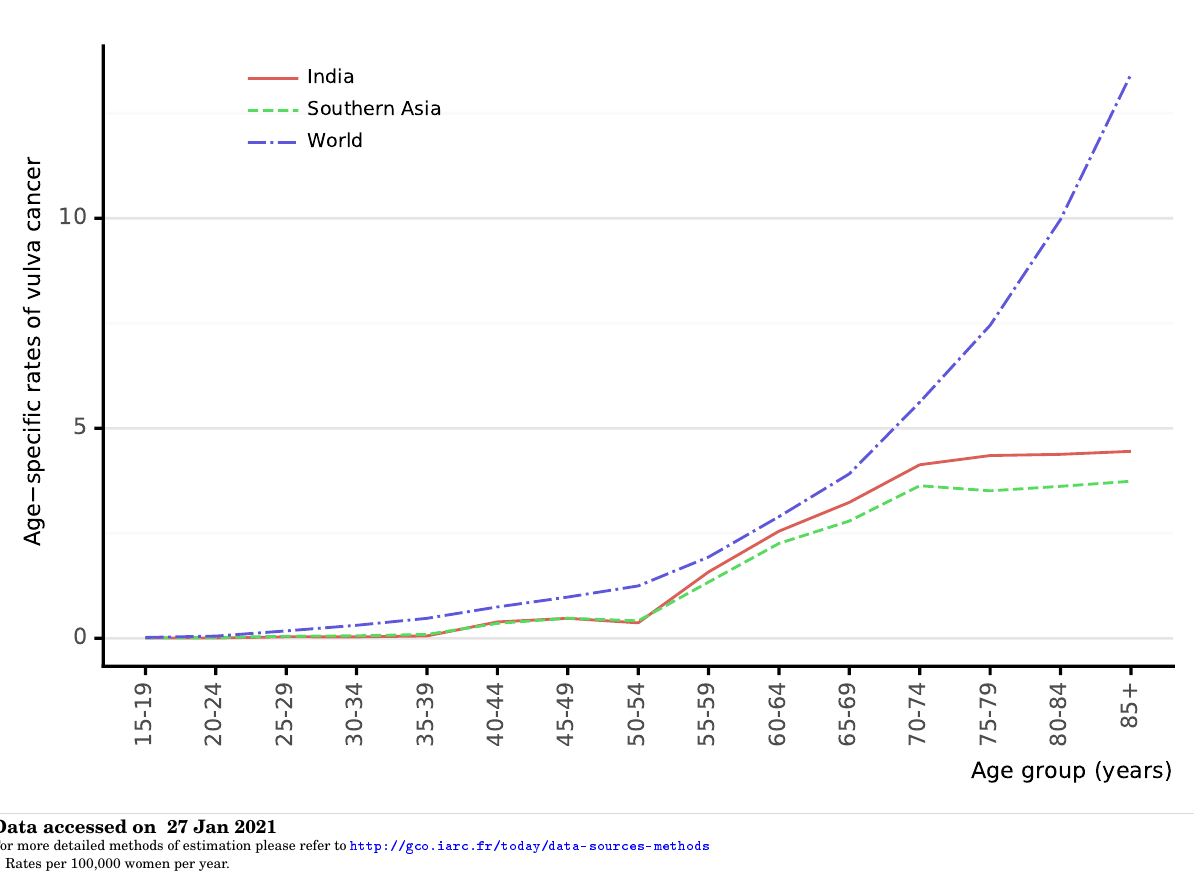
Figure 83: Comparison of age-specific vulva cancer incidence rates in India, within the region, and the rest of